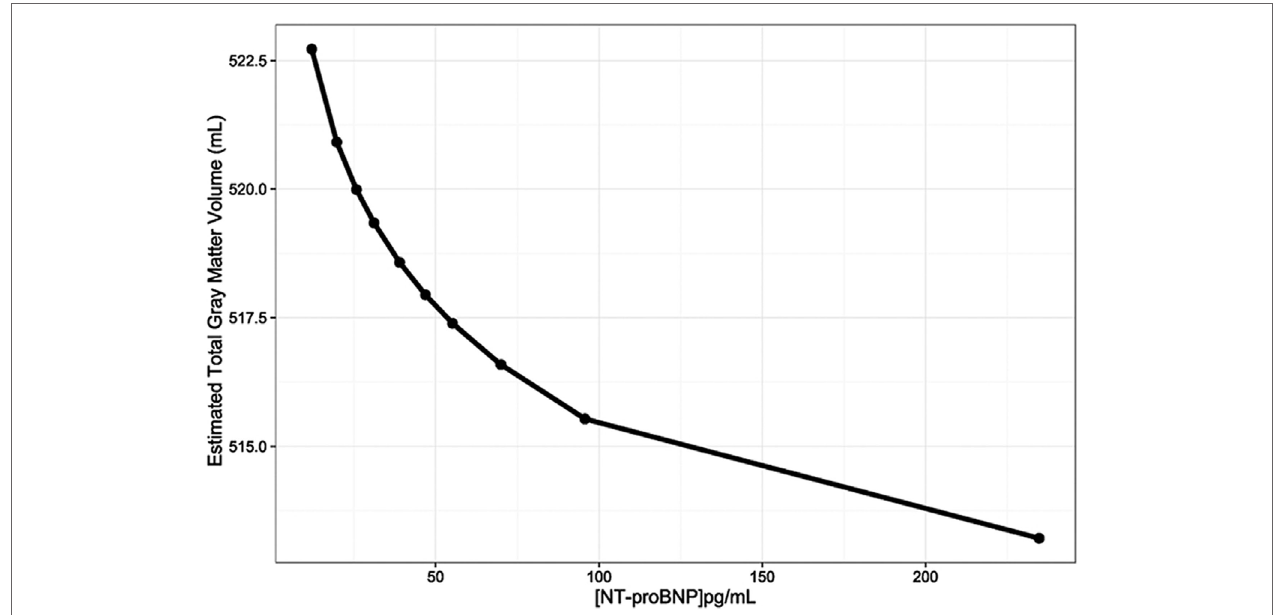
FigUre 1 | The relationship between gray matter volumes (mL) and N-terminal pro-brain natriuretic peptide (NT-proBNP) levels (pg/mL) adjusted for age, sex, race, and total intracranial volume (Model 1). The line was constructed by connecting the 10 total gray matter volume adjusted estimates for each NT-proBNP concentration that corresponds to the means of NT-proBNP